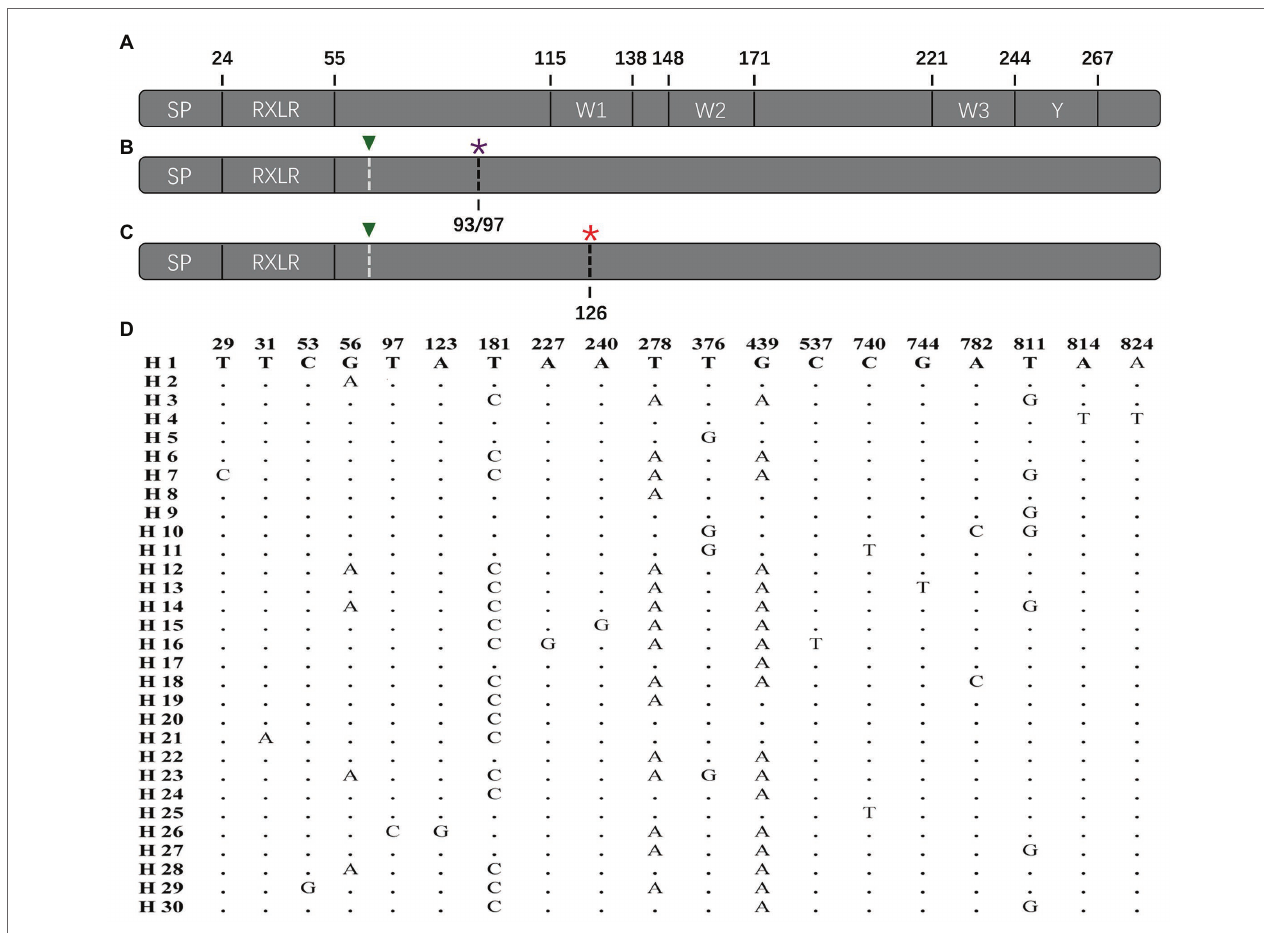
FIGURE 2 | Protein structure of P. infestans Avr4 effector deduced from the reference sequence and nucleotide structure of the Avr4 gene generated from the current study: (A) primary protein structure of reference isolate (KF188223) containing a signal peptide (SP), a conserved RxLR-dEER domain, three W (W1, W2, and W3) motif, and a conserved Y motif; (B) the structure of Avr4 gene with early terminations caused by the 194th nucleotide deletion. The 194th nucleotide deletion showed by white dashed line with green triangle and the stop codon caused by the 194th nucleotide deletion showed by the black dashed line with a purple asterisk; (C) structure of Avr4 gene with a potential early termination caused by the 376th point mutation after the 194th nucleotide deletion. The 194th nucleotide deletion showed by white dashed line with green triangle and the stop codon caused by the 376th point mutation showed by a black dashed line with a red asterisk; (D) polymorphic sites in the 30 nucleotide haplotypes of the Avr4 gene.